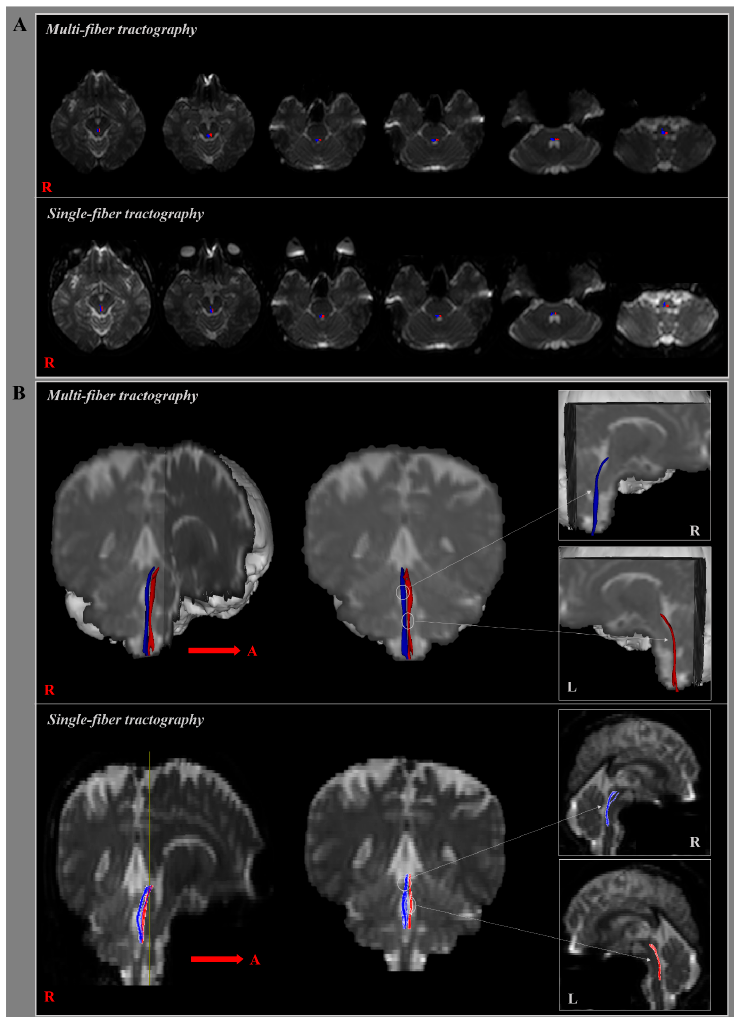
Figure 2. ( A ) The MLF resulting for B0 maps is shown at each level of the brainstem in a healthy subject according to type of DTI tractography. ( B ) The right (blue) and left MLF (red) are shown in coronal and sagittal plane in a healthy subject, using single and multi-fiber tractography.